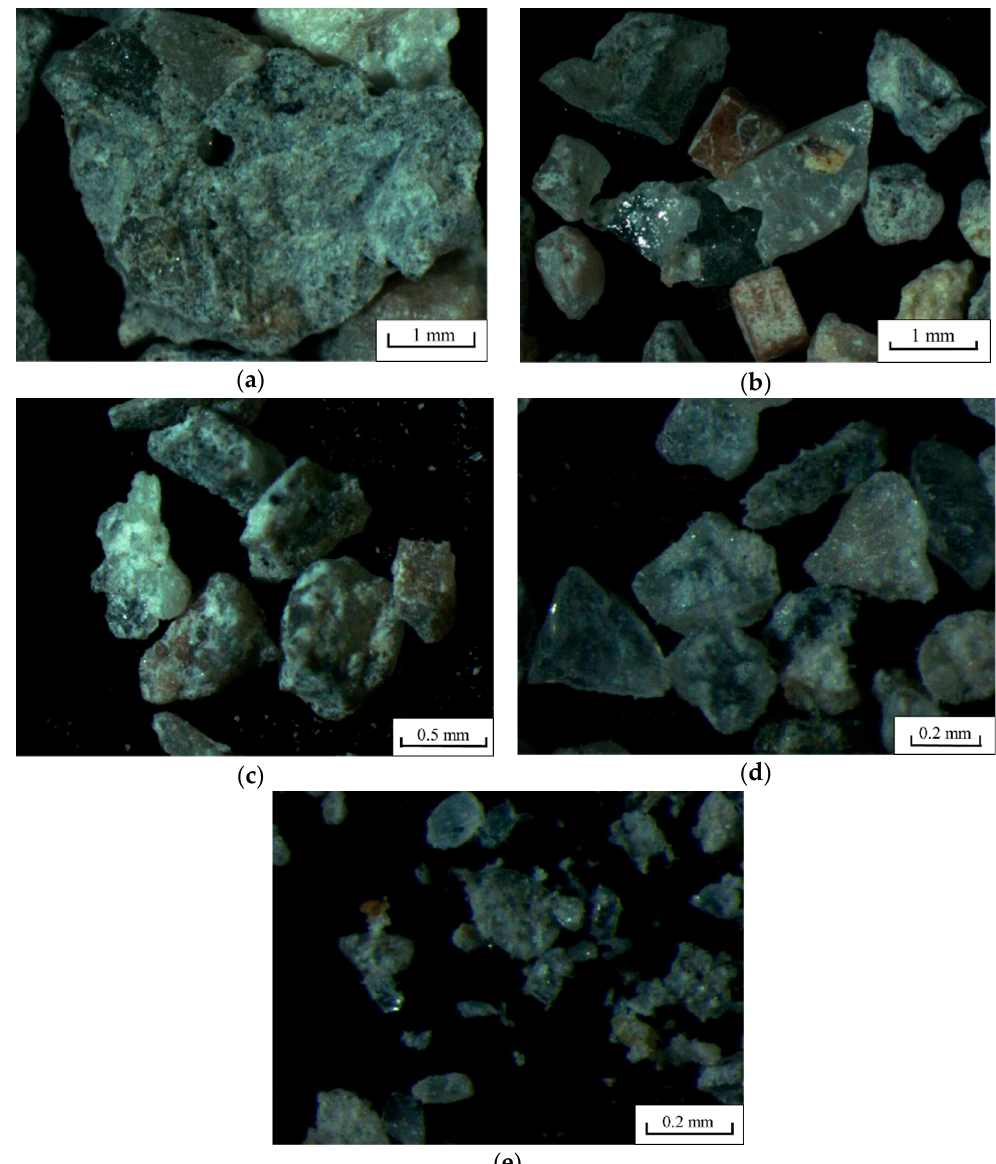
Figure 5. The appearance of the CRFA with different particle sizes under the stereomicroscope.